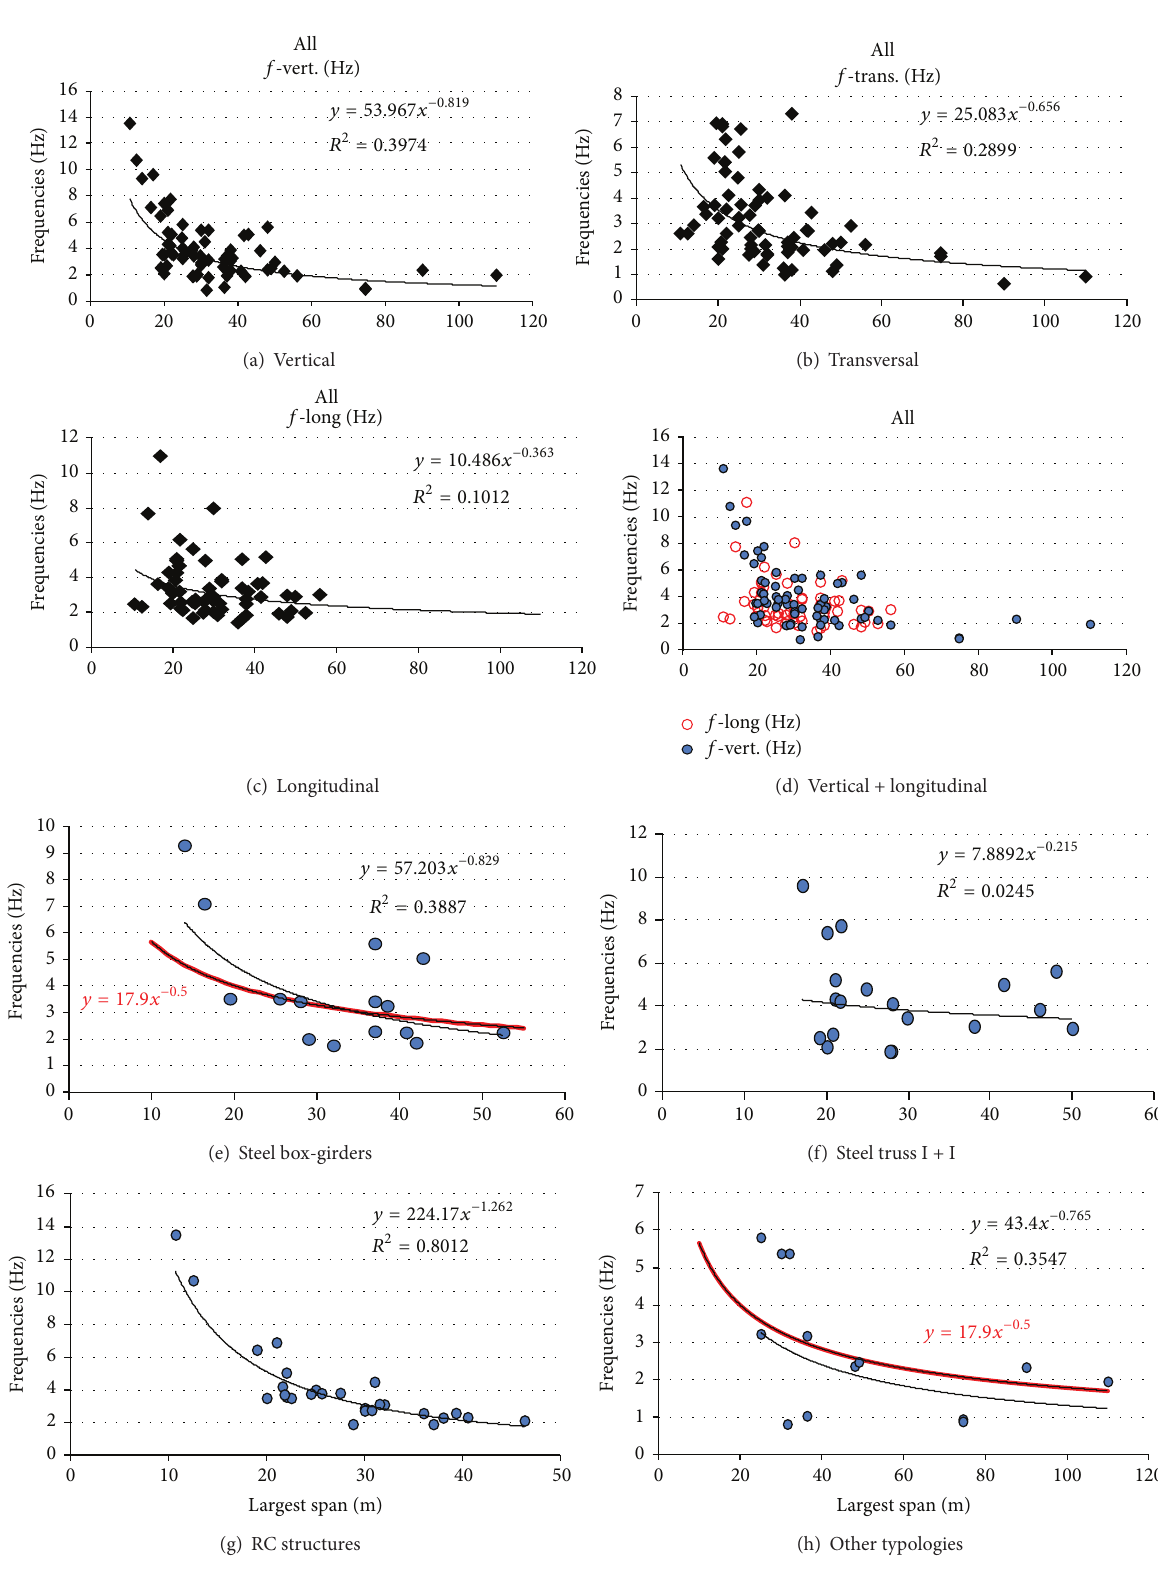
Figure 4: Frequencies of 1st mode in the three directions (T, L, and V) as a function of largest span: (a) to (c) all typologies for V, T, L, and (d) V + L; (e) to (h) vertical for steel box-girders, truss structures, RC structures, and other structures, respectively. Red curves are explained in Section